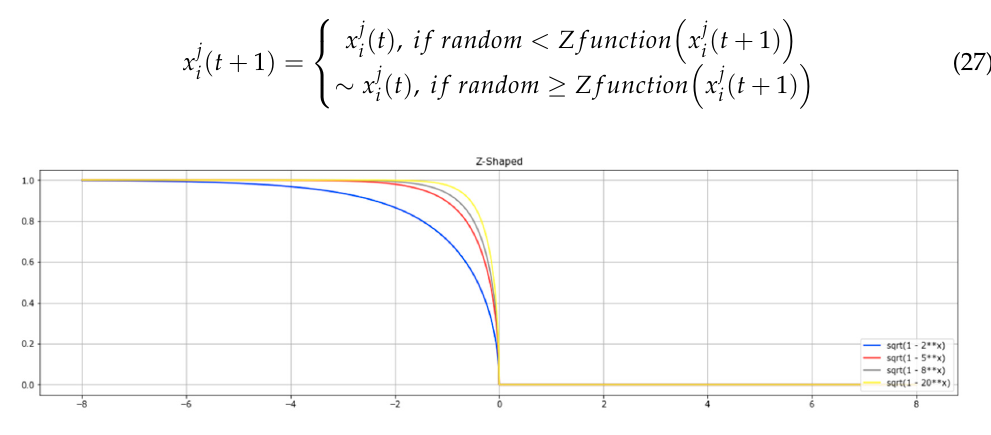
Figure 8. Z-shaped transfer function ( Z 1– Z 3).